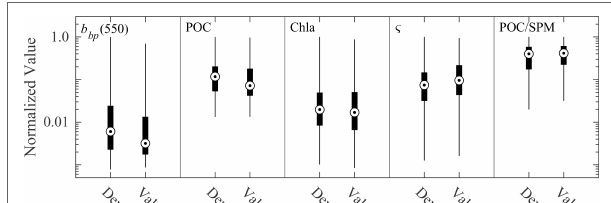
FIGURE 2 | Normalized non-parametric box plots of five variables in development (Dev) and validation (Val) datasets. The features of each box plot represent (from bottom to top) lower limit, 25 th percentile, 50 th percentile, 75 th percentile, and upper limit. Data have been normalized by maximum value of each metric from the development dataset. Maximum values are 0.34 m -1 , 816 mg m -3 , 16.6 mg m -3 , 1988 mg m -2 , and 0.69 for b bp (550), POC, Chla, ς , and POC/SPM,